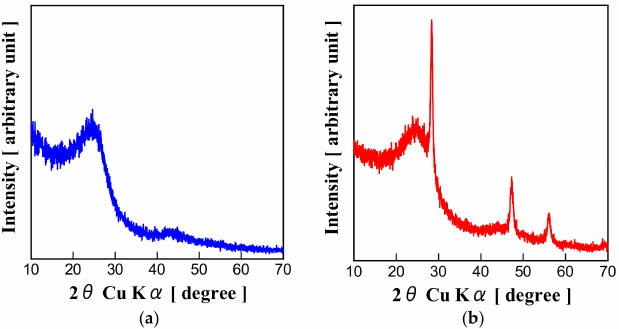
Figure 3. XRD patterns of: ( a ) TEOS Carbon; and ( b ) TEOS/Si Hybrid Carbon.